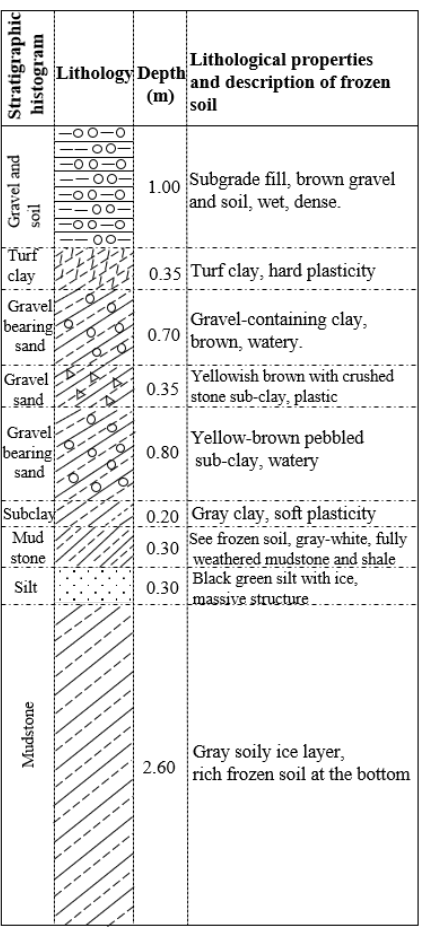
Figure 5. Lithology and stratigraphic column.